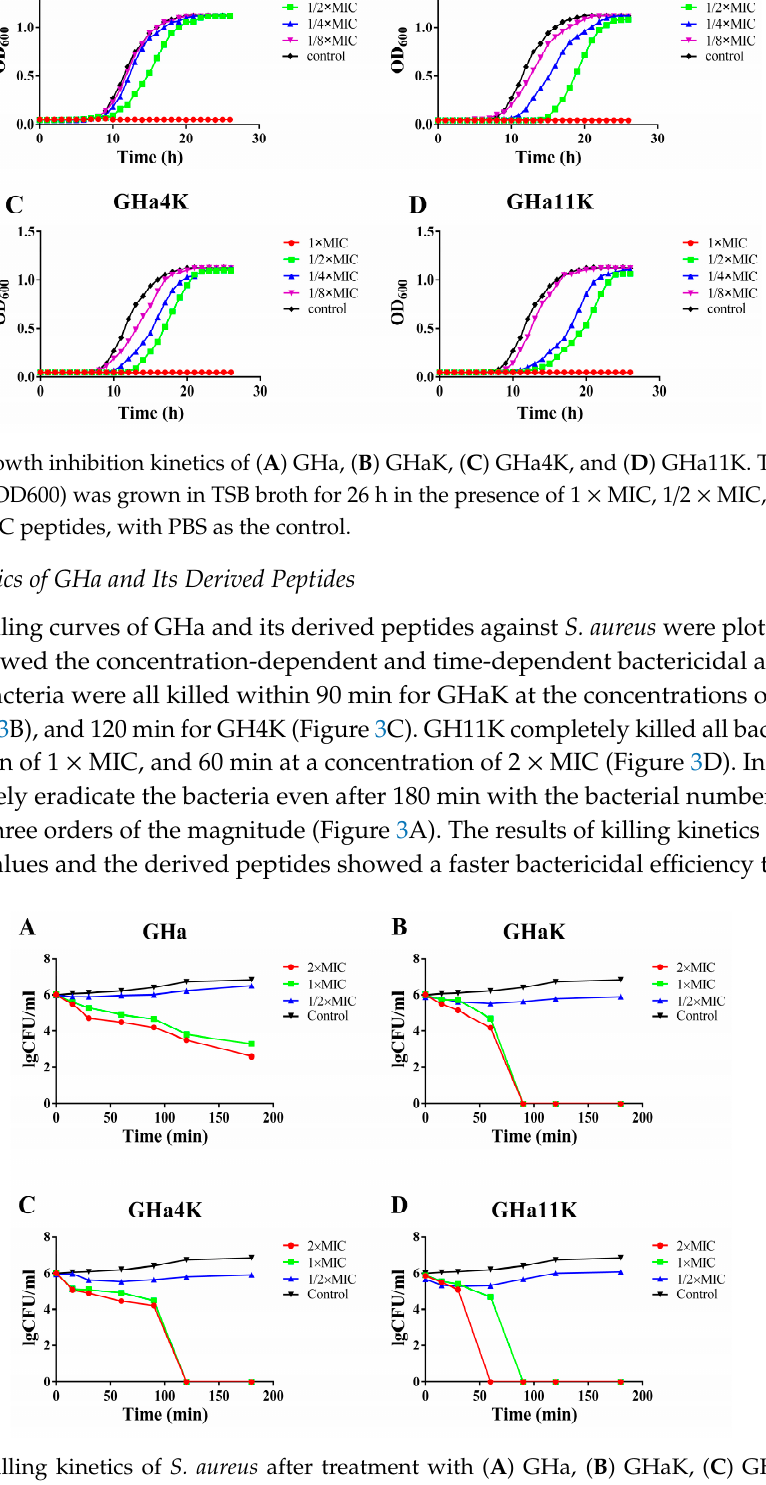
Figure 3. Killing kinetics of S. aureus after treatment with ( A ) GHa, ( B ) GHaK, ( C ) GHa4K, and ( D ) GHa11K at 1/2 ×MIC, 1 × MIC and 2 × MIC.